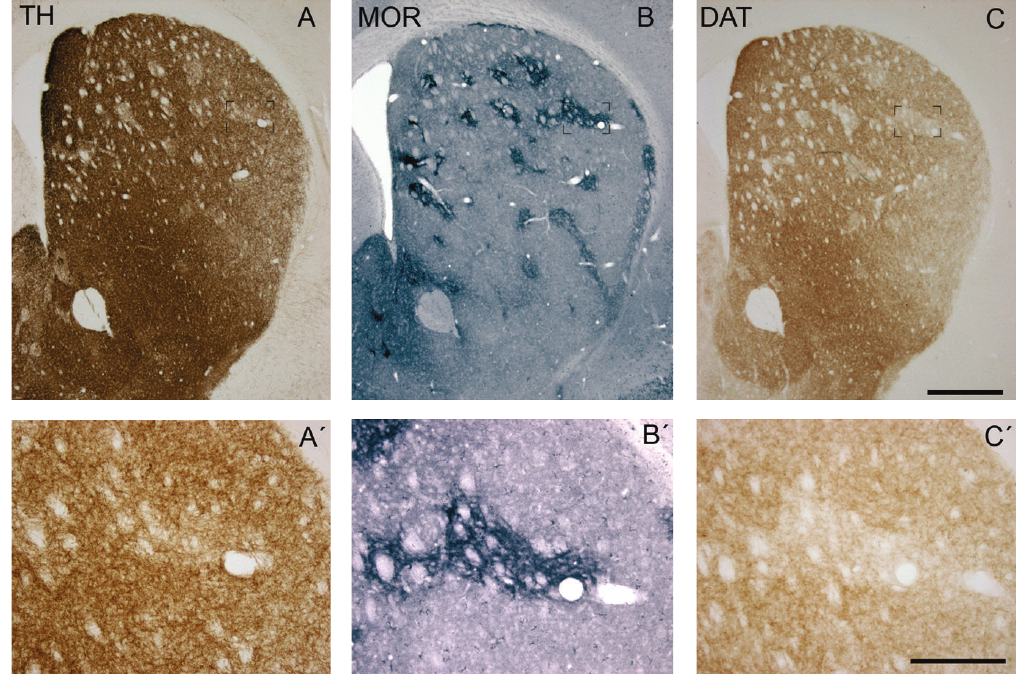
Figure 2: TH- and DAT-ir loss is predominant in striosomes. Serially adjacent sections from a mouse treated with METH stained for TH (A), MOR-1 (B), and DAT (C). Most striatal TH weak patches matched DAT weak patches. These areas corresponded with striosomes as demonstrated by MOR-1 immunostaining. A 󸀠 –C 󸀠 show an example of a striosome at higher magnification. Bar indicates 500 𝜇 m (A–C) and 200 𝜇 m, (A–C 󸀠 ). Modified from Granado et al.